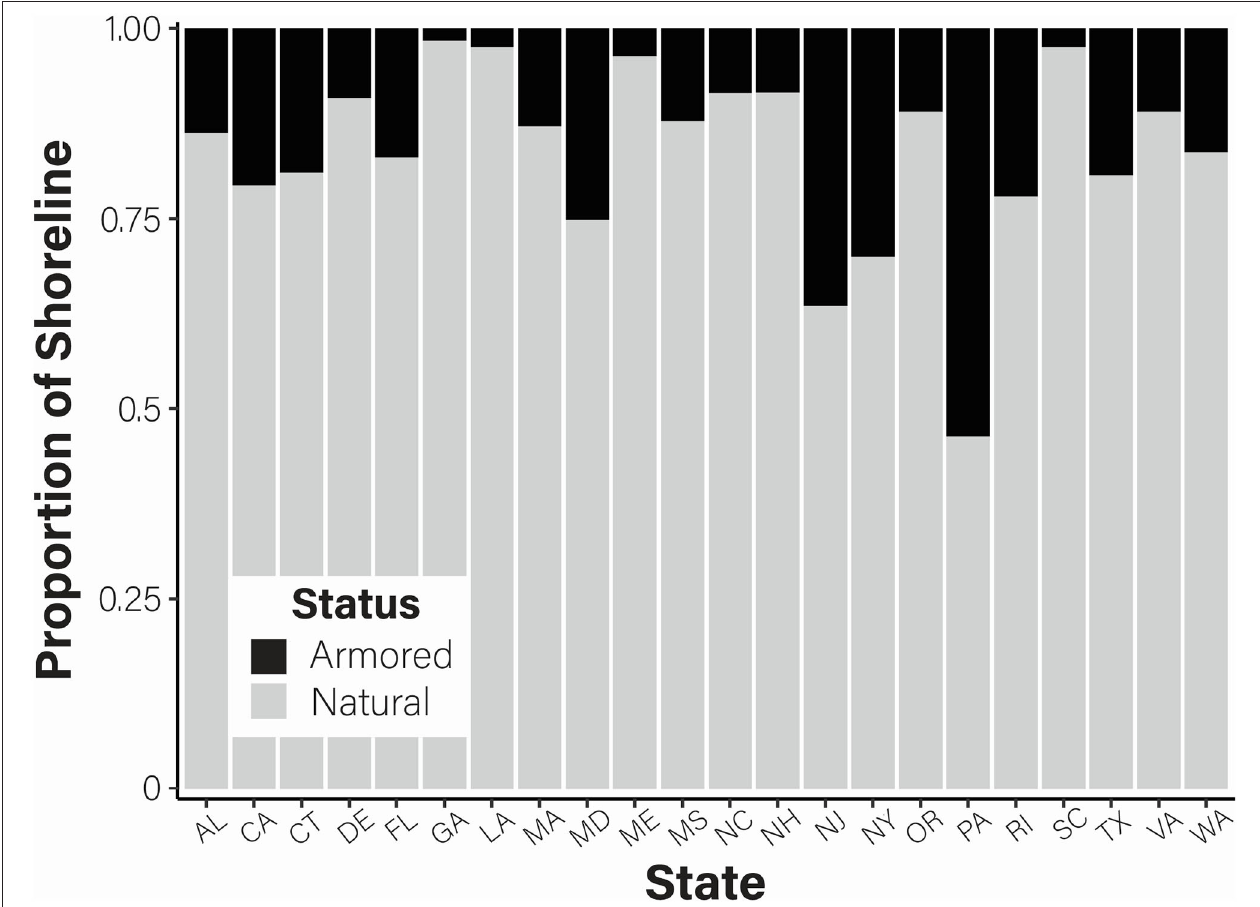
FIGURE 3 | Proportion of natural (gray) and armored (black) shoreline in each U.S. coastal state. Note that direct comparisons of shoreline estimates across states are limited because the most recent update year and methodologies for mapping the shoreline varies from state to state. These data represent the best available national estimate of shoreline hardening in the United